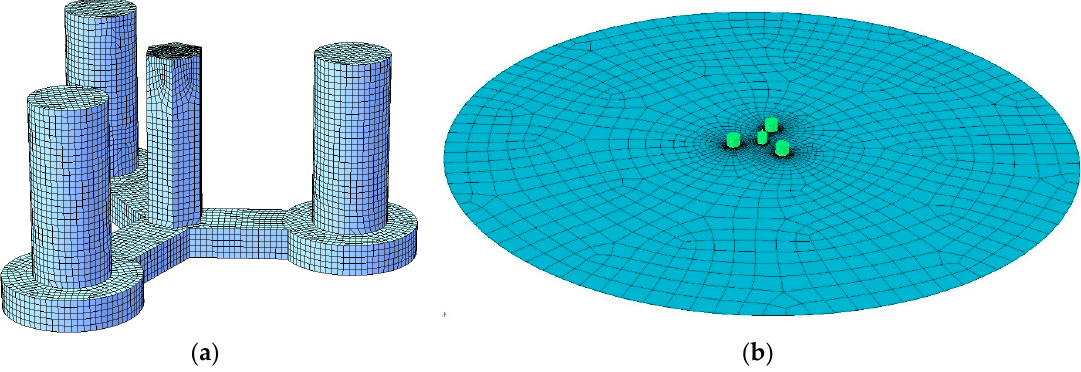
Figure 9. Grids for the hydrodynamics computation: ( a ) Panel model for the ConFloat semi-submersible platform; ( b ) Free surface grids.